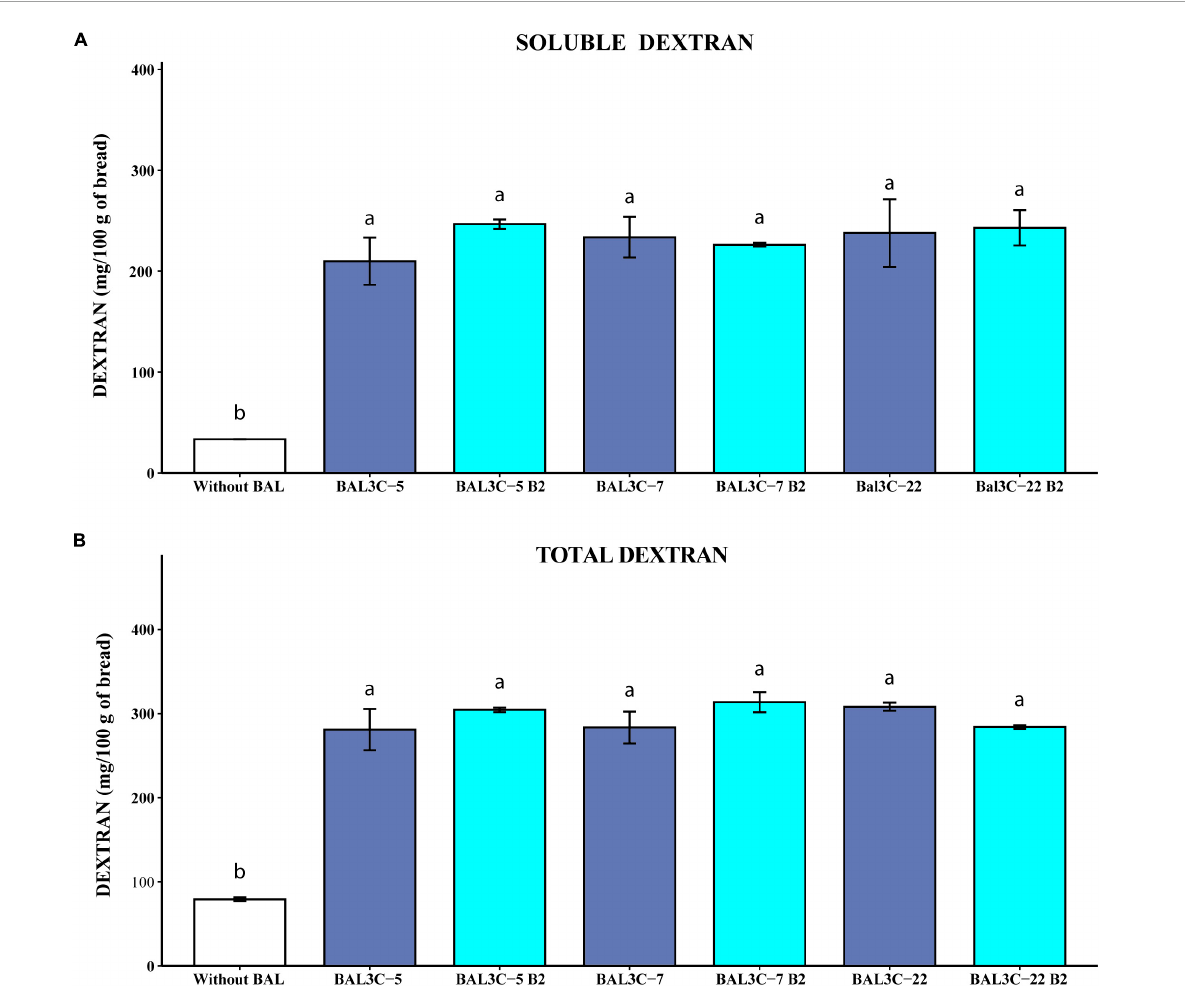
FIGURE6 Determination of soluble and total dextran levels in breads produced with Weissella cibaria strains. Levels of water soluble dextran (soluble) (A) or dextran extracted after acidic and thermal treatments and hydrolyzed with dextranase (total) (B) present in the breads are indicated. The means of two determinations and the standard deviations are indicated. Different superscript letters indicate that the levels differed significantly ( p ≤ 0.05, see details of statistical analysis in Supplementary Figure 7 ).